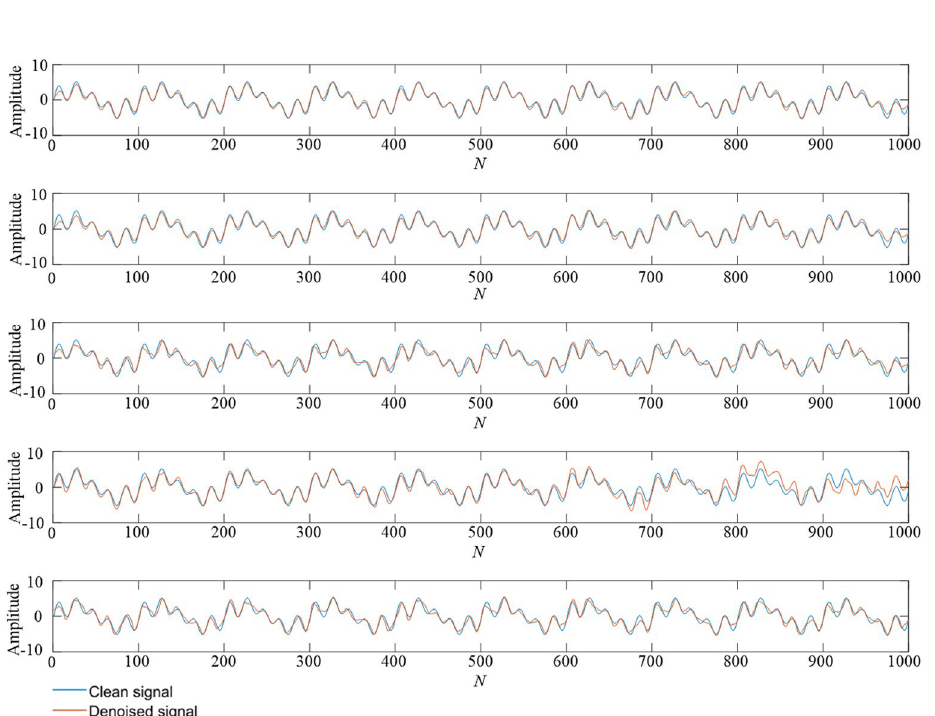
Figure 10. A comparison of denoising effect under 0 dB. From top to bottom: ( 1 ) TS-WOA-VMD-CA-WT; ( 2 ) WOA-VMD-CA-WT; ( 3 ) TS-VMD-CA-WT; ( 4 ) EMD-CA-WT; ( 5 )